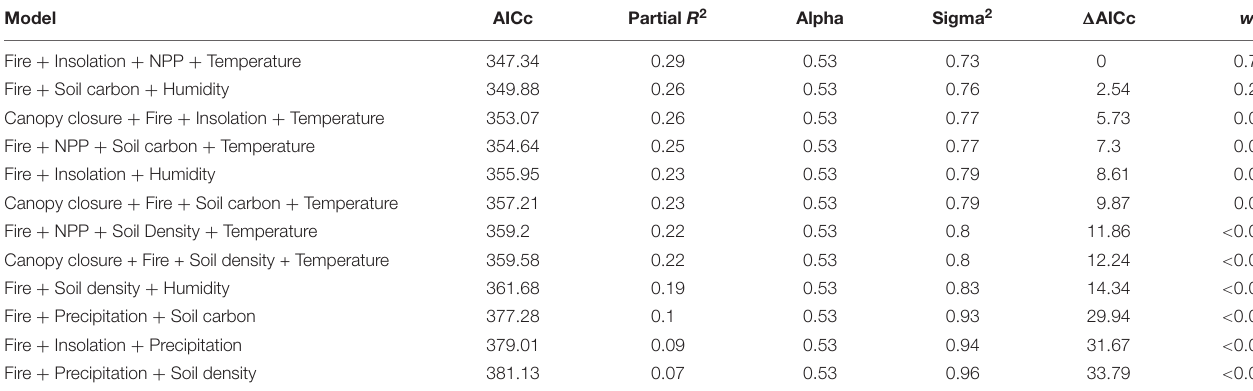
TABLE 1 | The 12 regression models tested by